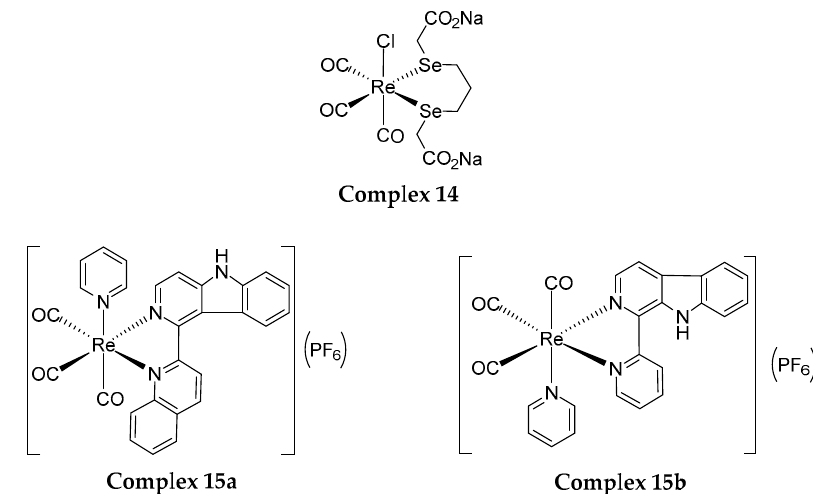
Figure 6. Di ff erent ligands complexed to a Re(I) tricarbonyl core forming di ff erent Re(I) tricarbonyl Figure 6. Different ligands complexed to a Re(I) tricarbonyl core forming different Re(I) tricarbonyl complexes with di ff erent cytotoxic activity on cancer cell complexes with different cytotoxic activity on cancer cell lines.